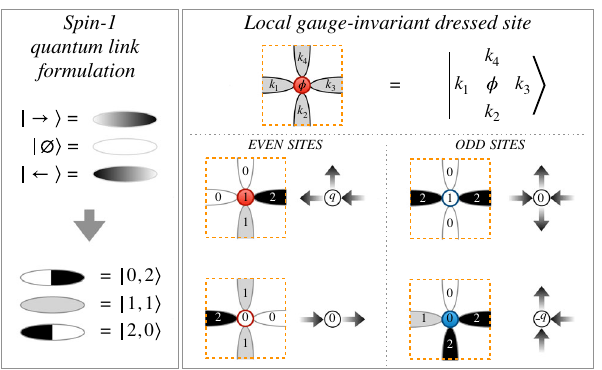
FIG. 2. Mapping of the gauge-field states in the spin-1 representation to the fermionic Fock states. Each half-link is constructed by employing two species of Dirac fermions. The link symmetry formally reduces the total number of states to only the three allowed states with two fermions. We therefore construct the local gauge-invariant dressed site by gluing each single matter site together with its neighboring half-links. In the four examples, notice how the quantum number ϕ ¼ 1 represents the presence (absence) of a charge (anticharge) in the even (odd)